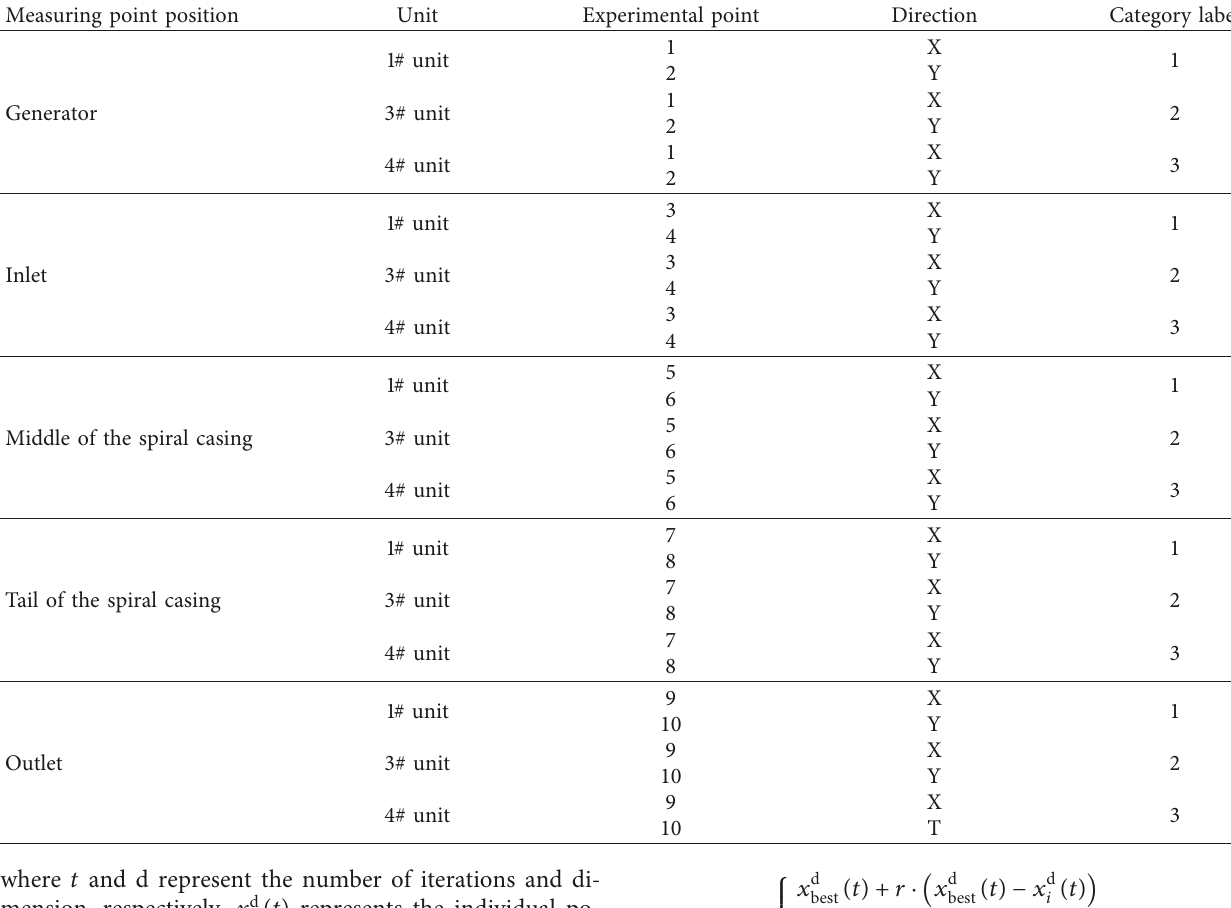
Table 2: Classification of experimental